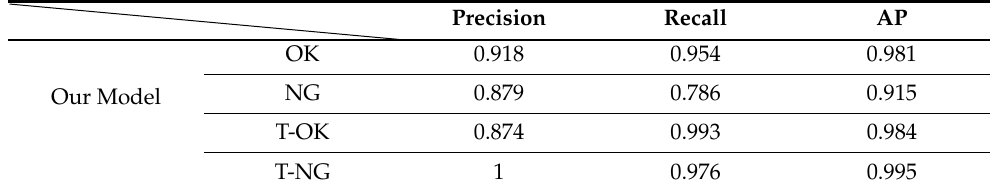
Table 8. Performance resolution based on hyperparameters.